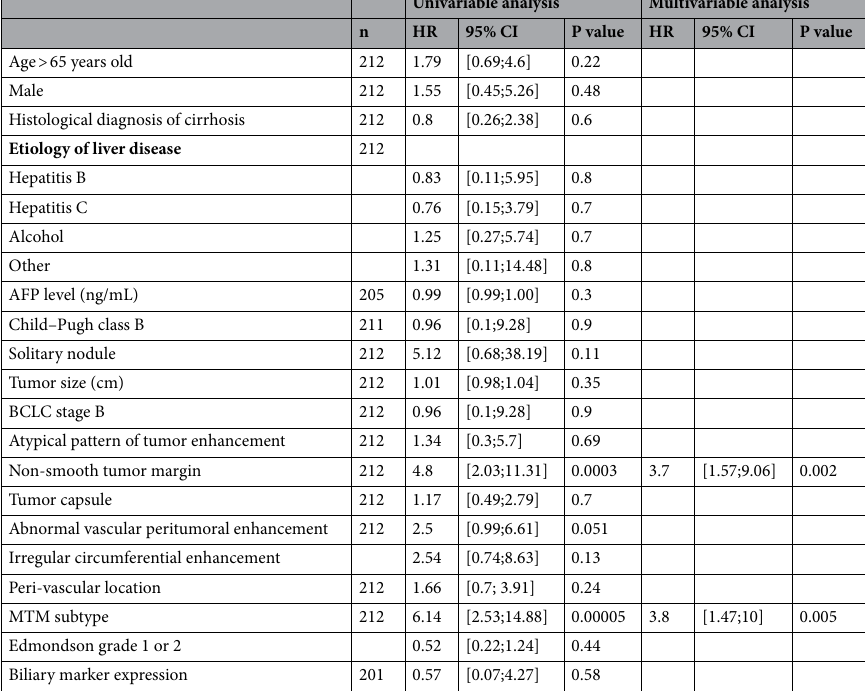
Table 2. Univariable and multivariable analysis of baseline characteristics associated with aggressive intra- segmental recurrence. AFP, alphafoetoprotein level; BCLC, Barcelona Clinic Liver Classification; HR, hazard ratio; MTM, macrotrabecular